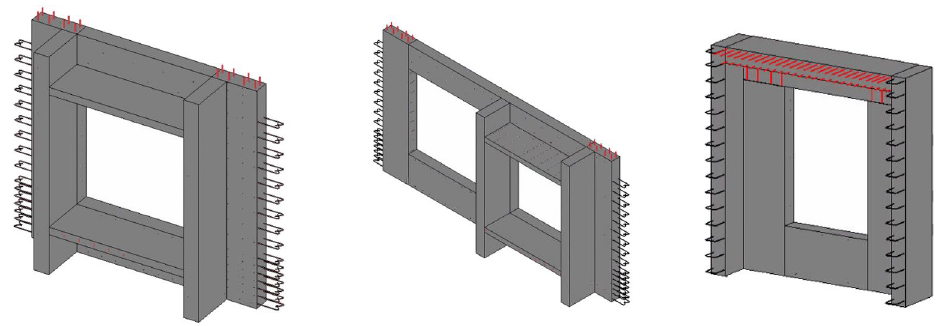
Figure 11. Non-regular PC components—Floating windows.